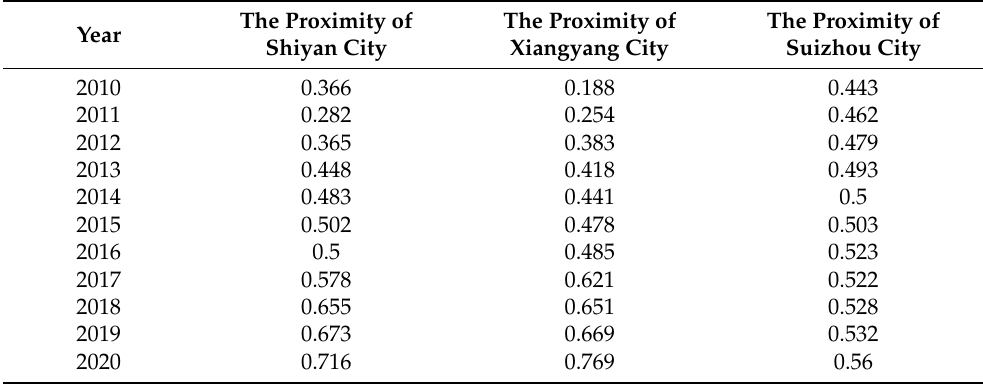
Table 4. The proximity of the comprehensive benefits of Shiyan City, Xiangyang City, and Suizhou